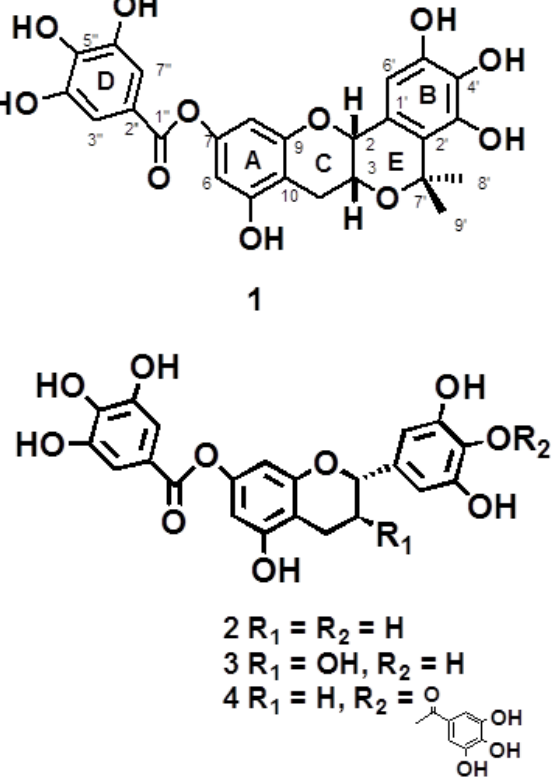
Figure 1. The structures of compounds 1 – 4 isolated from P. clypearia .